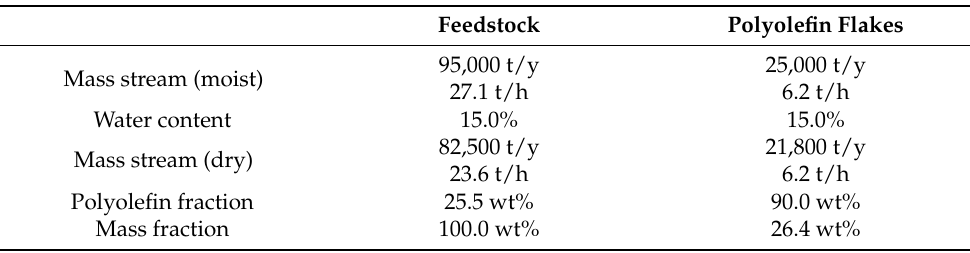
Table 15. Material and production parameters for the business case.